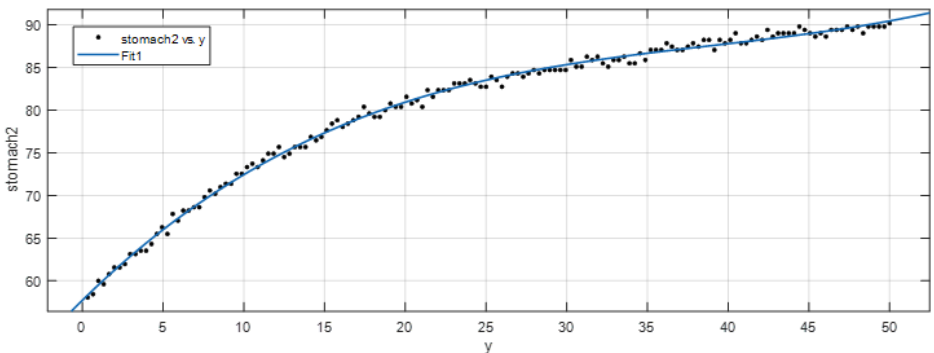
Figure 20. Fitting of the values of the portion of the graph highlighted by the yellow rectangle with the polynomial